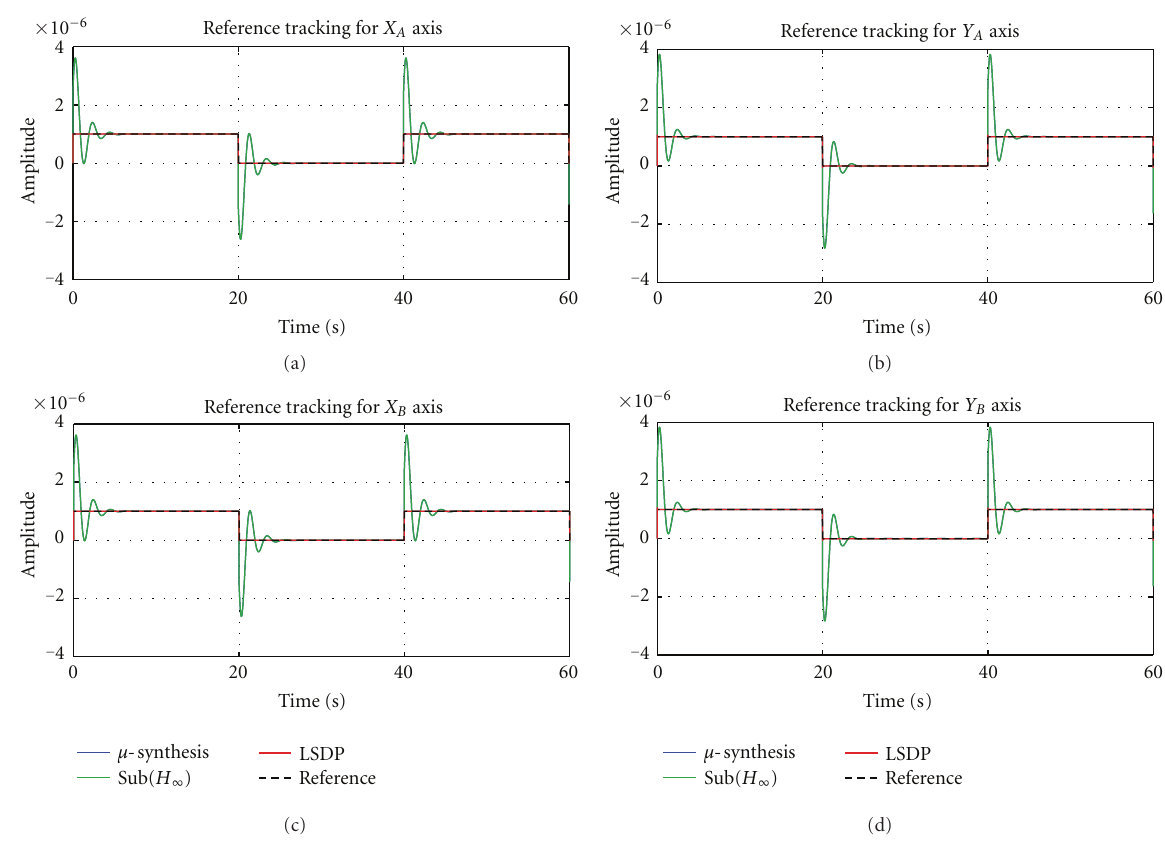
Figure 11: Comparison via simulation for reference tracking